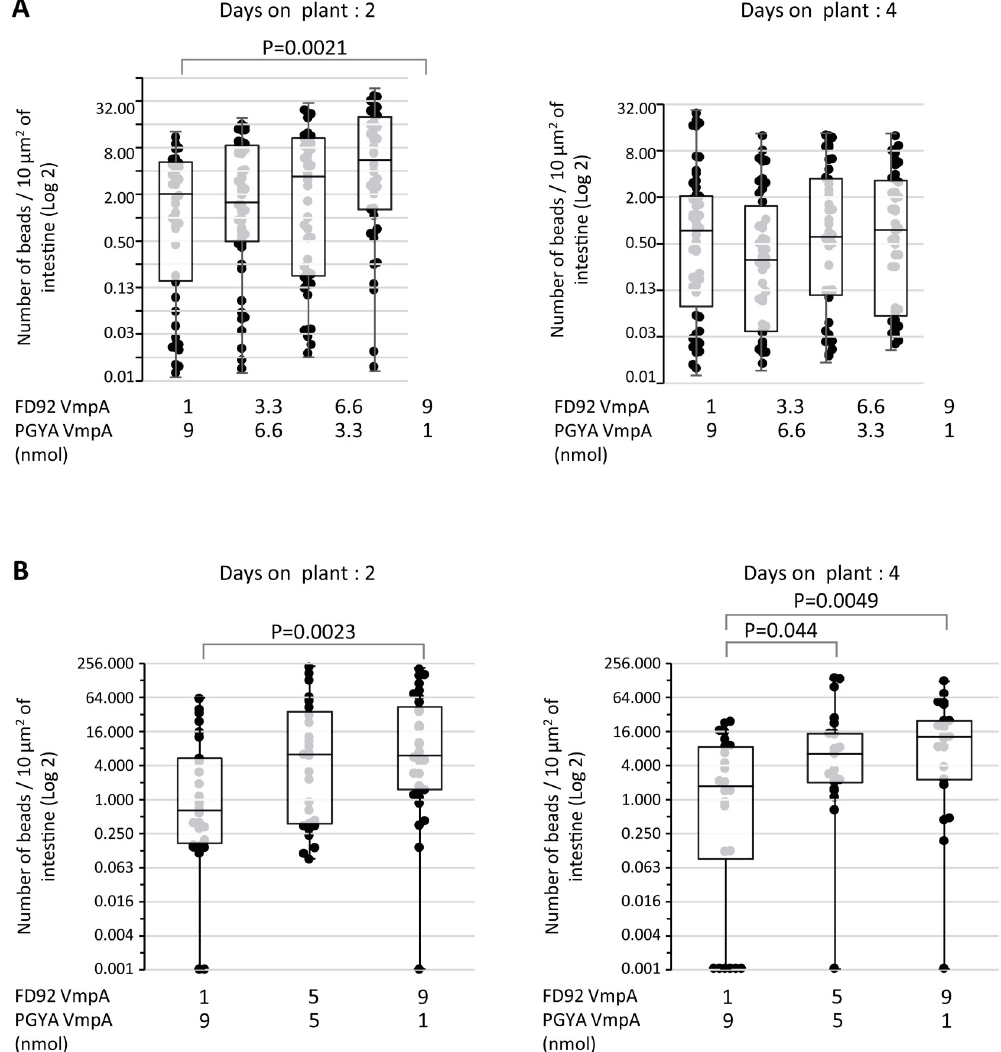
Fig 7. Number of FD92 VmpA-His 6 -coated latex beads in midgut of Euscelidius variegatus and Scaphoideus titanus after ingestion and fluorescence observations. Number of fluorescent beads coated with various concentrations of FD92 VmpA-His 6 in E . variegatus middle midgut (A) or S . titanus middle midgut (B). After eating HEPES-sucrose containing the fluorescent beads, insects were maintained two and four days on broad bean before the intestine were dissected. A total of 43 to 60 insects per group were examined for E . variegatus (pool of 3 independent experiments) and 21 to 32 for S . titanus (pool of 2 independent experiments). P-value found with the Kruskal-Wallis test of R were indicated above de graph. Dots on the box-plots indicate Individual